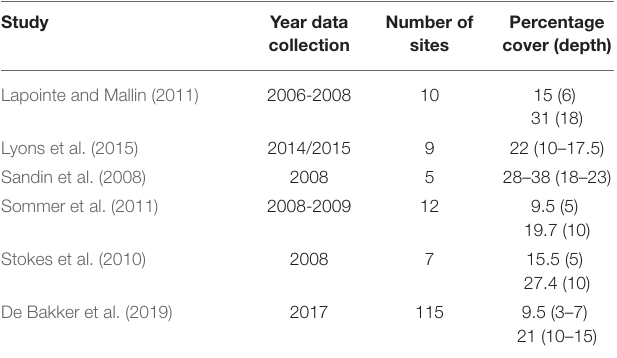
TABLE 1 | Coral cover estimates for the leeward reef of Bonaire by other researchers.